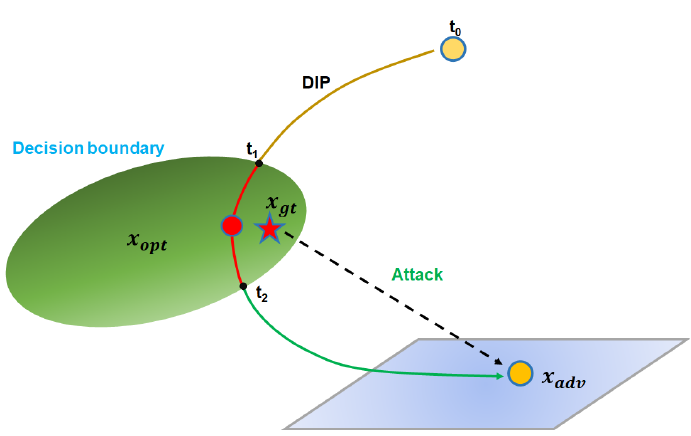
Figure 4. DIP image reconstruction of an adversarial